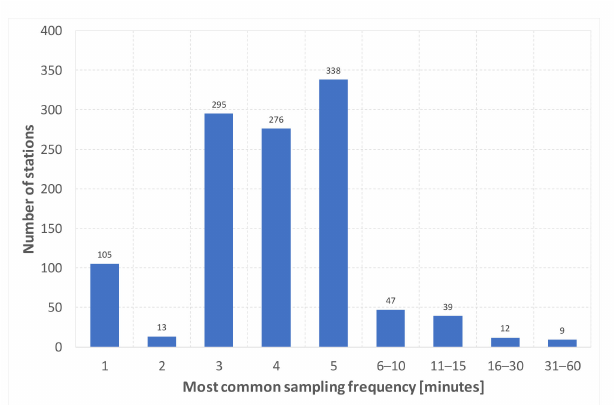
Figure 3. Most common sampling frequency for each of the MNW stations (1134 total) active on average in the month of January 2022 in